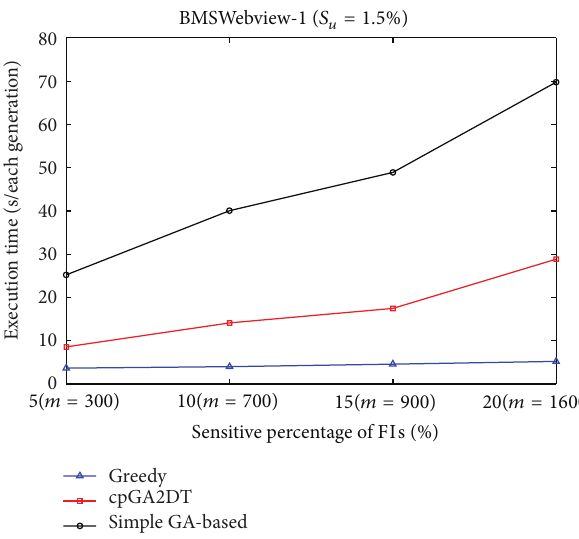
Figure 8: Comparisons of execution time at various sensitivity percentages for BMSWebview-1